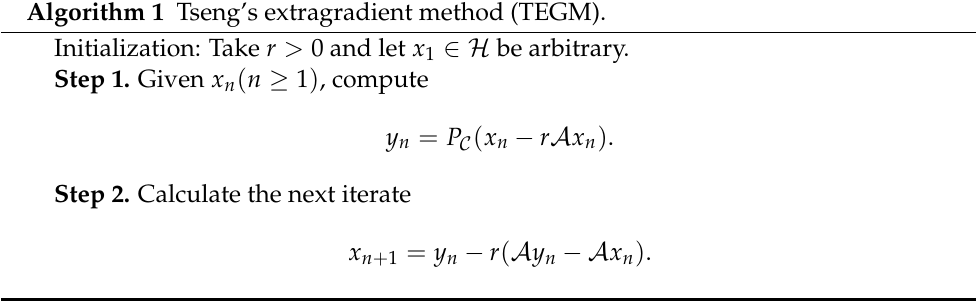
Algorithm 1 Tseng’s extragradient method